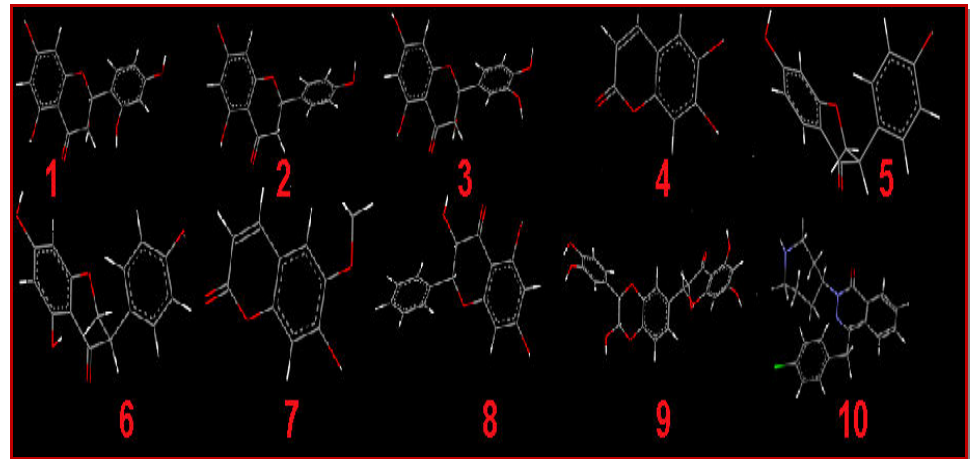
Figure 2: The optimized ligand molecules (1 morin, 2 naringenin, 3 taxifolin, 4 esculatin, 5 daidzein, 6 genistein, 7 scopoletin, 8 galangin, 9 silbinin and 10